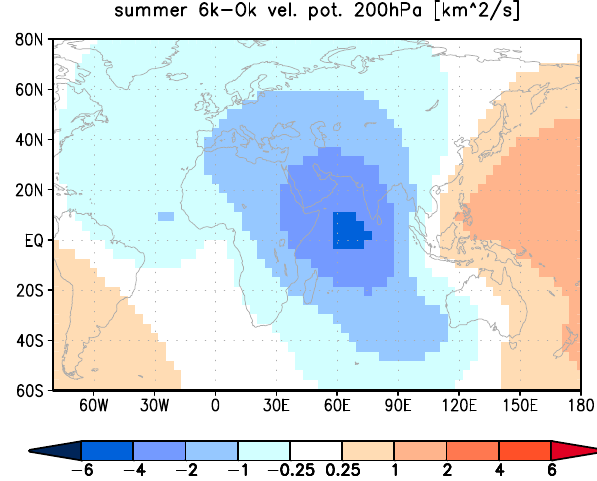
Fig. 12. Differences in upper-tropospheric velocity potential (200hPa, [km 2 /s]) between mid-Holocene (6k) and present-day (0K) climate, attributed to the ocean-atmosphere interaction and averaged over the summer season. Negative values represent divergence, positive values convergence.